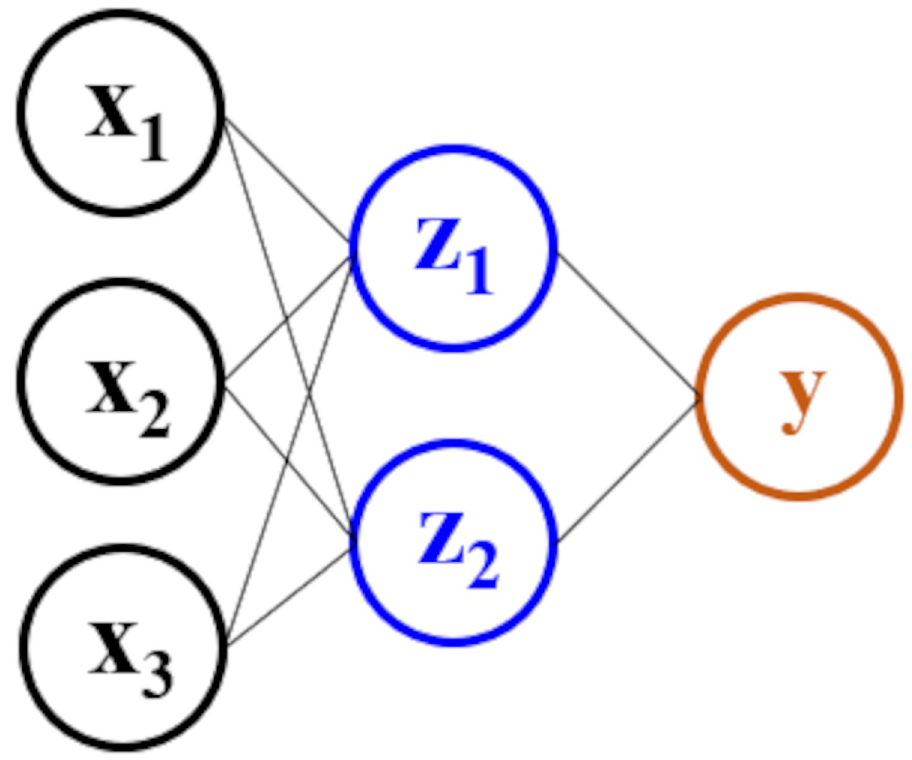
Fig 8. A two-layer neural network with a hinge-loss-like objective